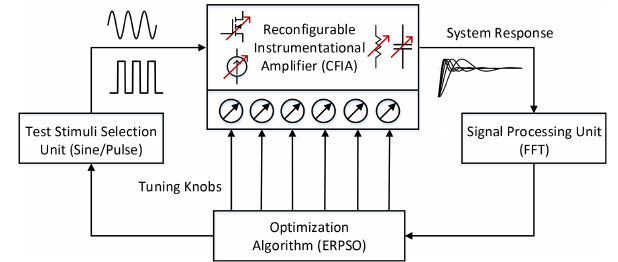
Figure 2. Block diagram of the proposed design methodology for